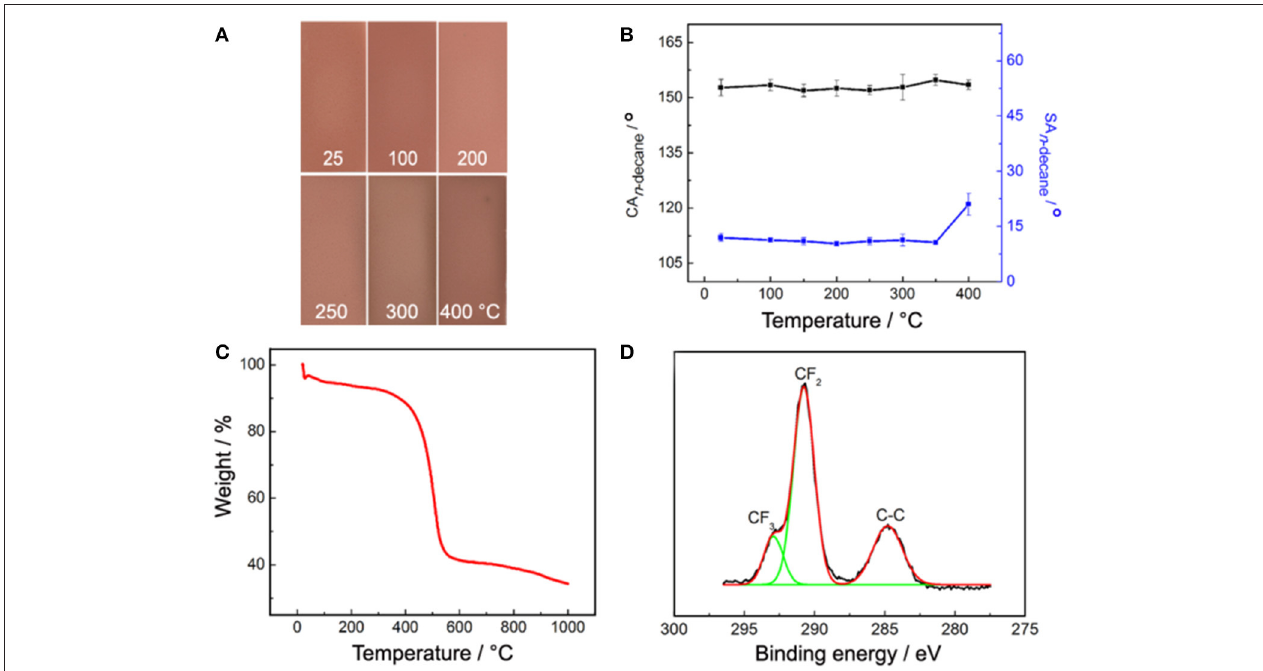
FIGURE 8 | (A) Images and (B) CA n − decane and SA n − decane of the PAL/IOR@fluoroPOS coatings after kept at different temperature for 1h, (C) TGA curve and (D) high-resolution C 1s XPS spectrum of the coating after kept at 400 ◦ C for 1h. C PAL / IOR = 14g L − 1 , t grinding = 20min, C PFDTES = 27.2mM, C TEOS = 4.5mM.